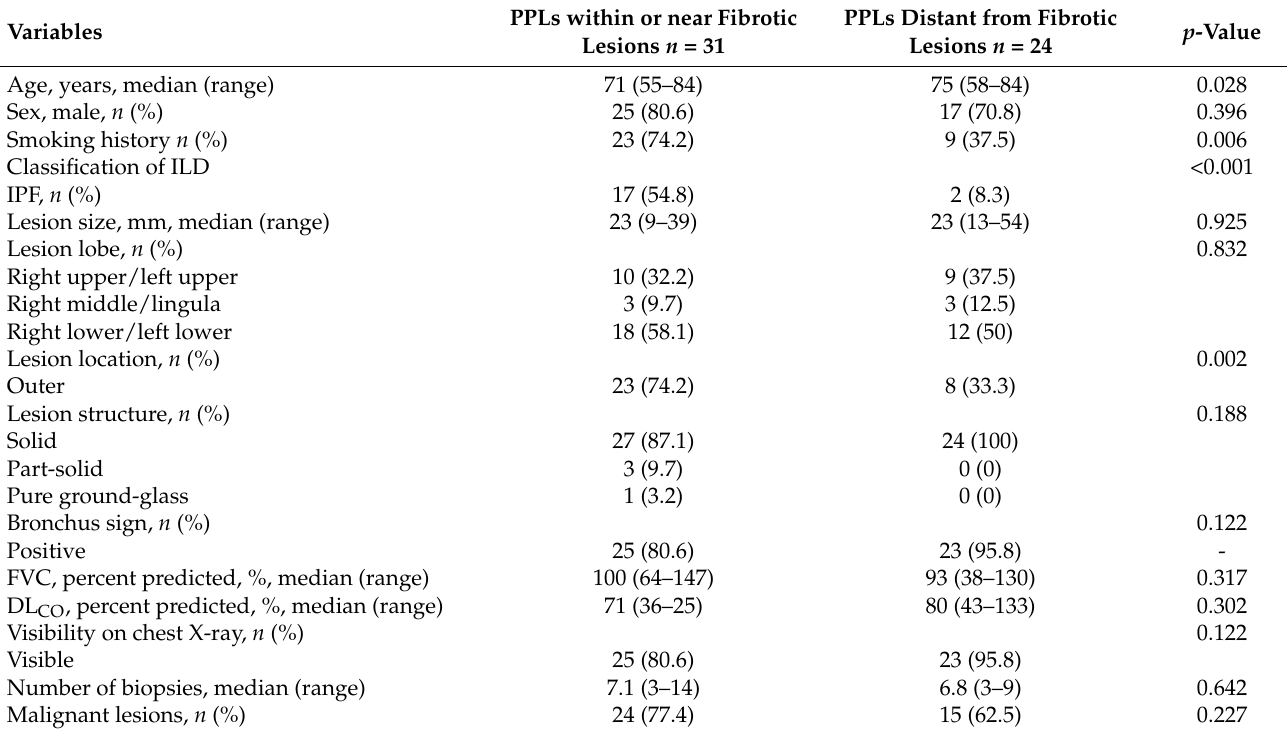
Figure 2. Flow diagram of our study. Table 1. Characteristics of the patients and their lesions in the two groups.